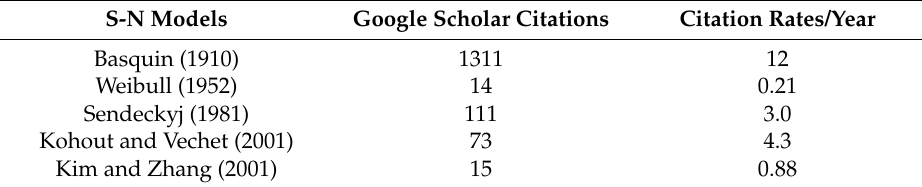
Table 3. Citations of S-N curve models available in the Google Scholar as of 23 May